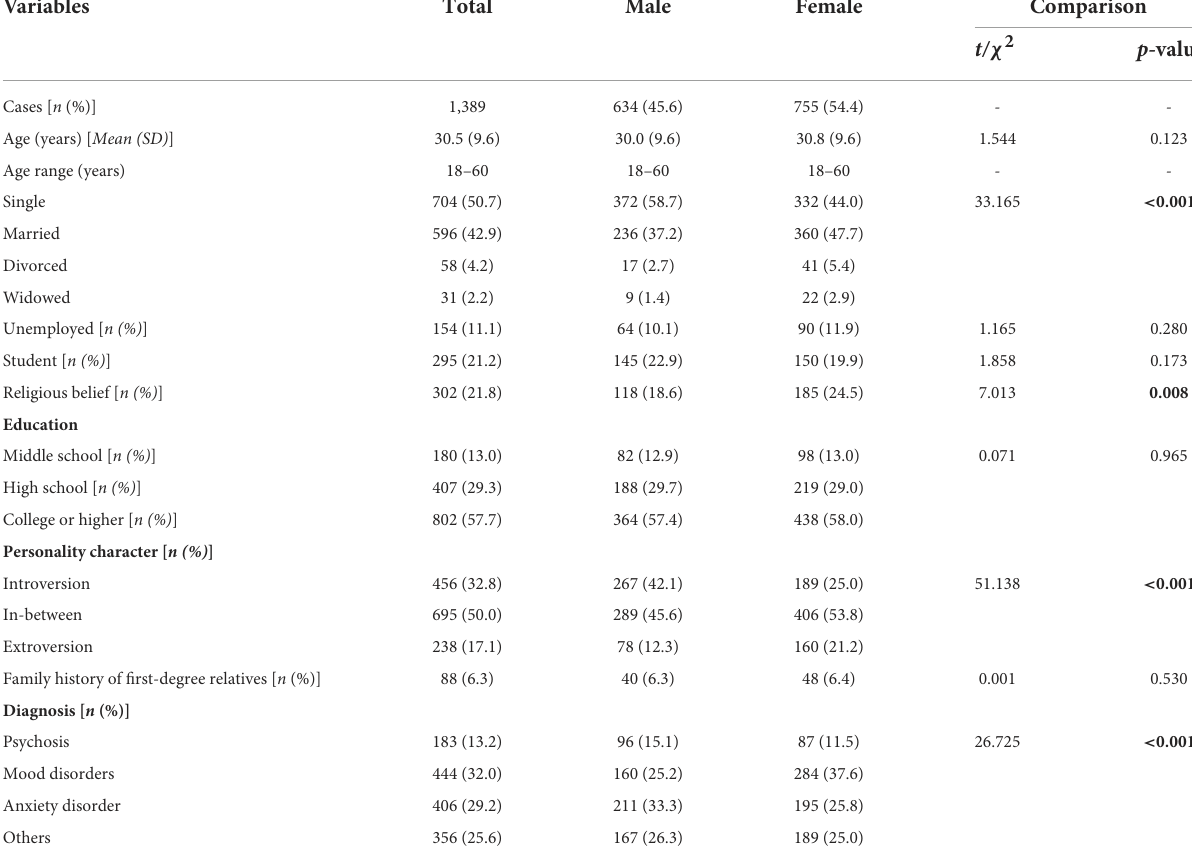
TABLE 1 Demographic and clinical characteristics in male and female